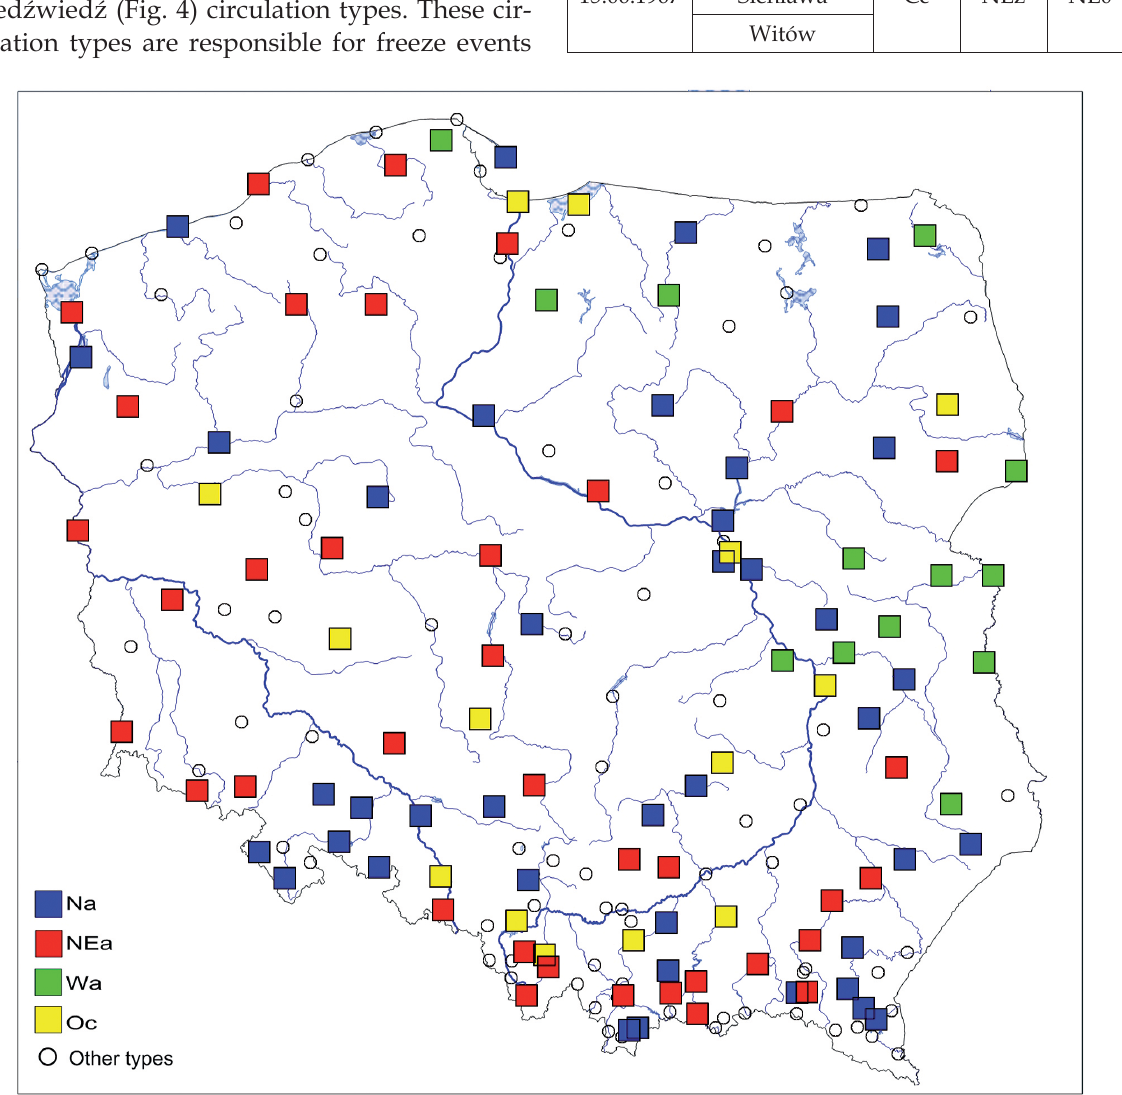
Fig. 3. Spatial distribution of circulation types responsible for the latest spring freezes (according to the Lityński